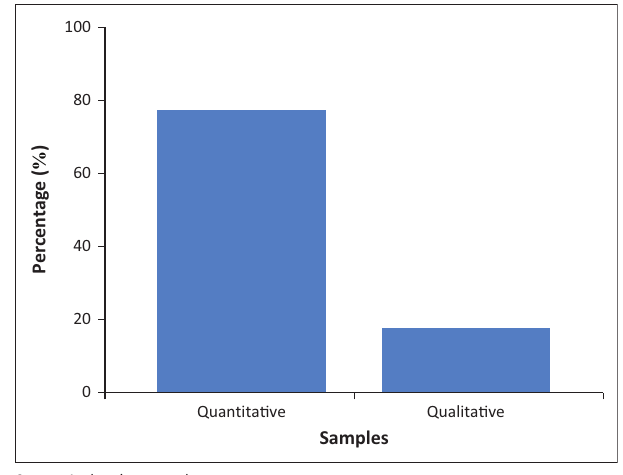
FIGURE 3: Percentage of participants in the quantitative and qualitative